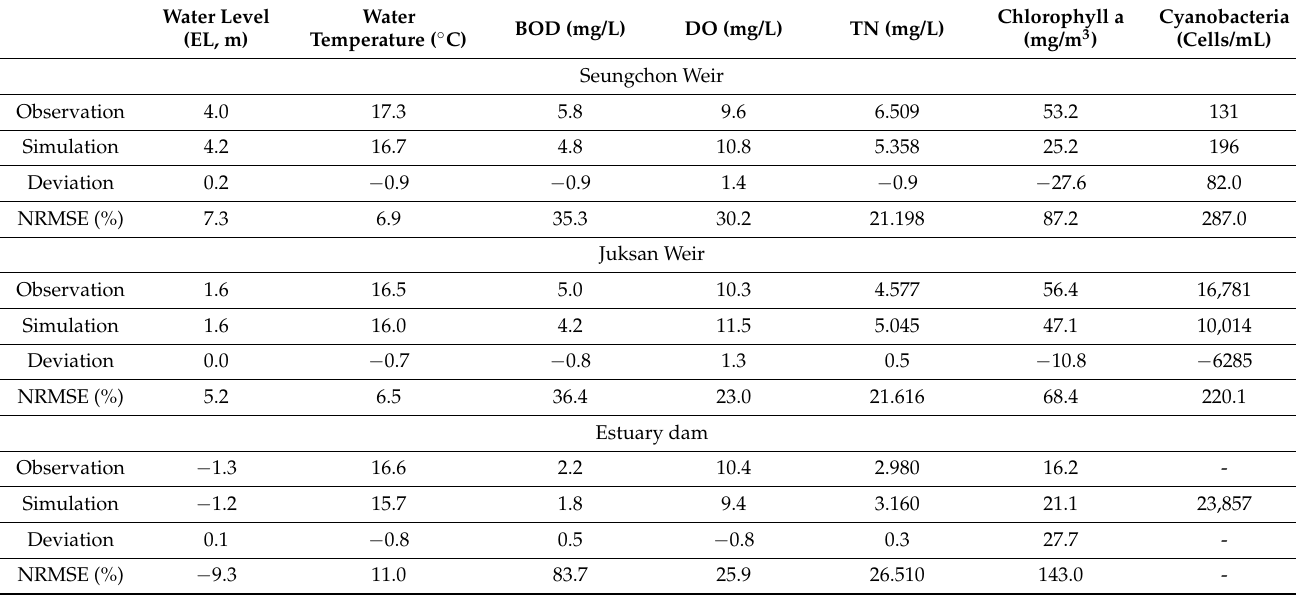
Table 6. Statistical summary of simulated and observed water quality at the Seungchon Weir, Juksan Weir, and estuary dam for 2018.